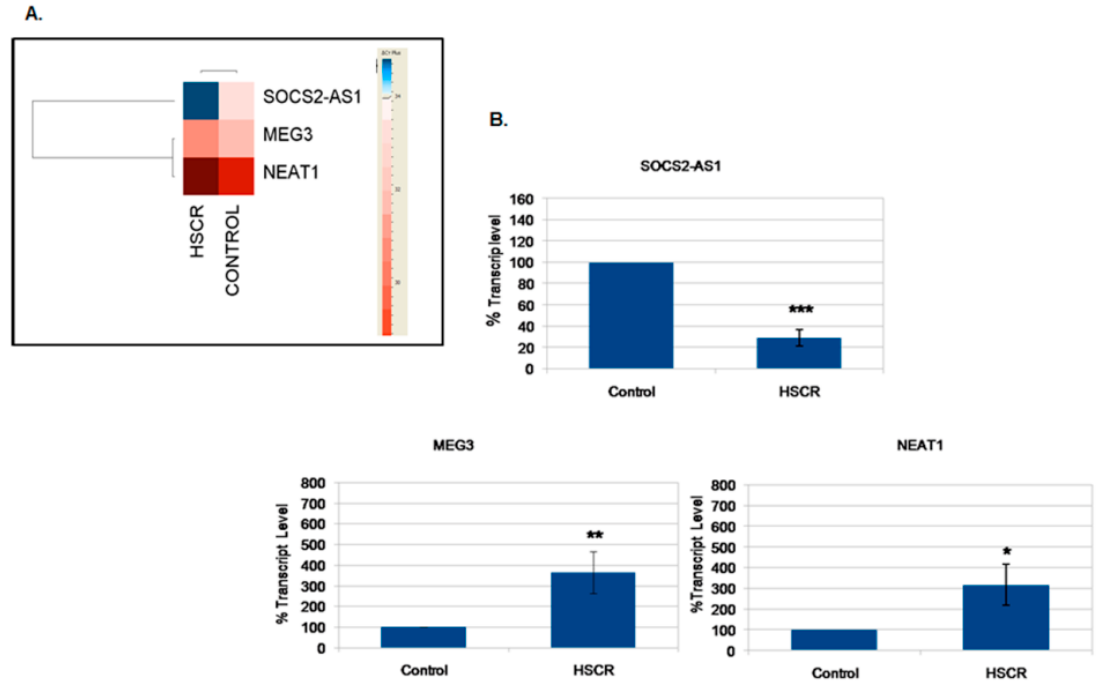
Figure 2. LncRNAs with different transcript levels in Hirschsprung disease enteric precursor cells (HSCR-EPCs) . ( A ) The Heat map represents the differential transcript levels of the lncRNA in HSCR-EPCs, the upregulation (red) and downregulation (blue) are shown. The color scale indicates the ∆ C t plus, shown on the right side. C t = 34. ( B ) Graphics show the percentages of transcript level of each lncRNA ( SOC2-AS1, MEG3 and NEAT1 ) in EPCs from HSCR patients and controls. * p value < 0.05, ** p value < 0.01 and *** p value < 0.001.